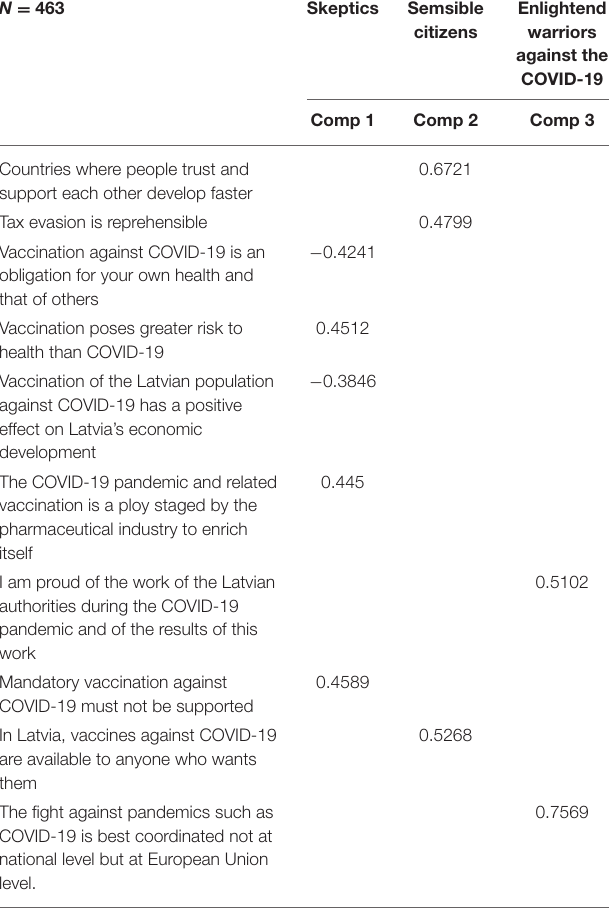
TABLE 3 | The dominant opinion groups in Latvia in relation to the vaccination against COVID-19 (15). N =